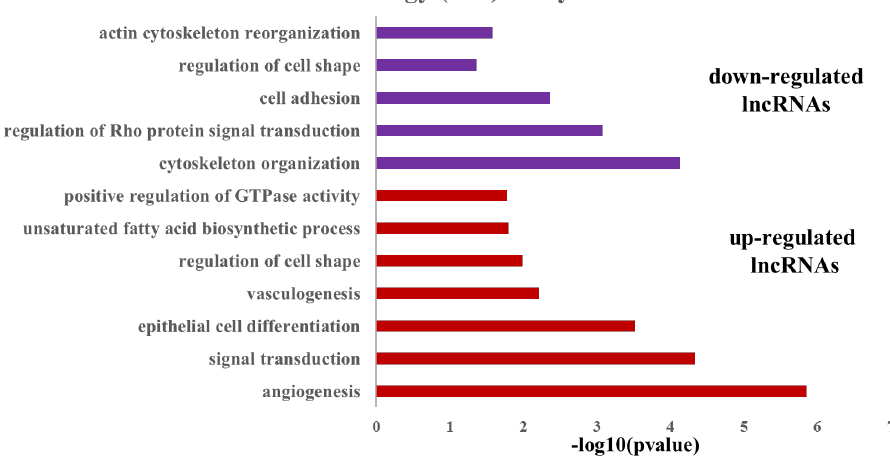
Figure 2. Gene ontology analysis of the co-expressed genes with the differentially expressed lncRNAs (DElncRNAs).